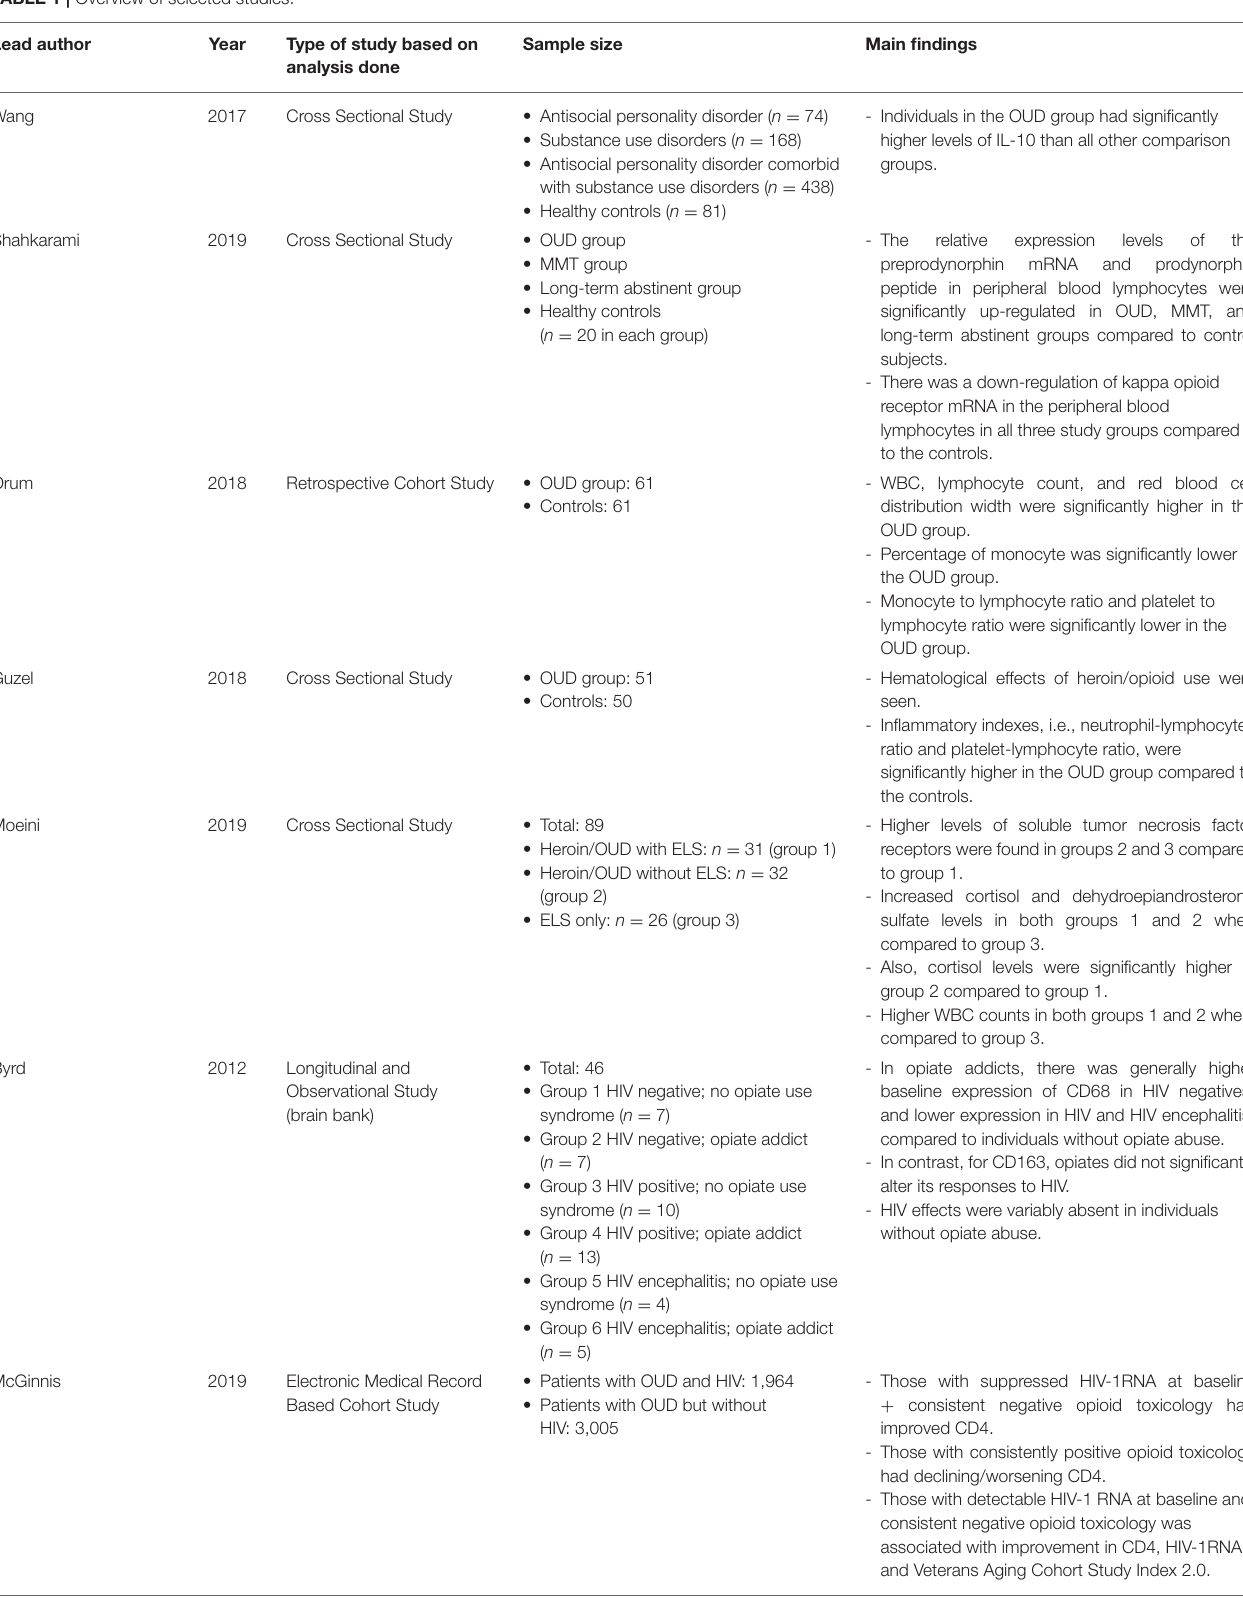
TABLE 1 | Overview of selected